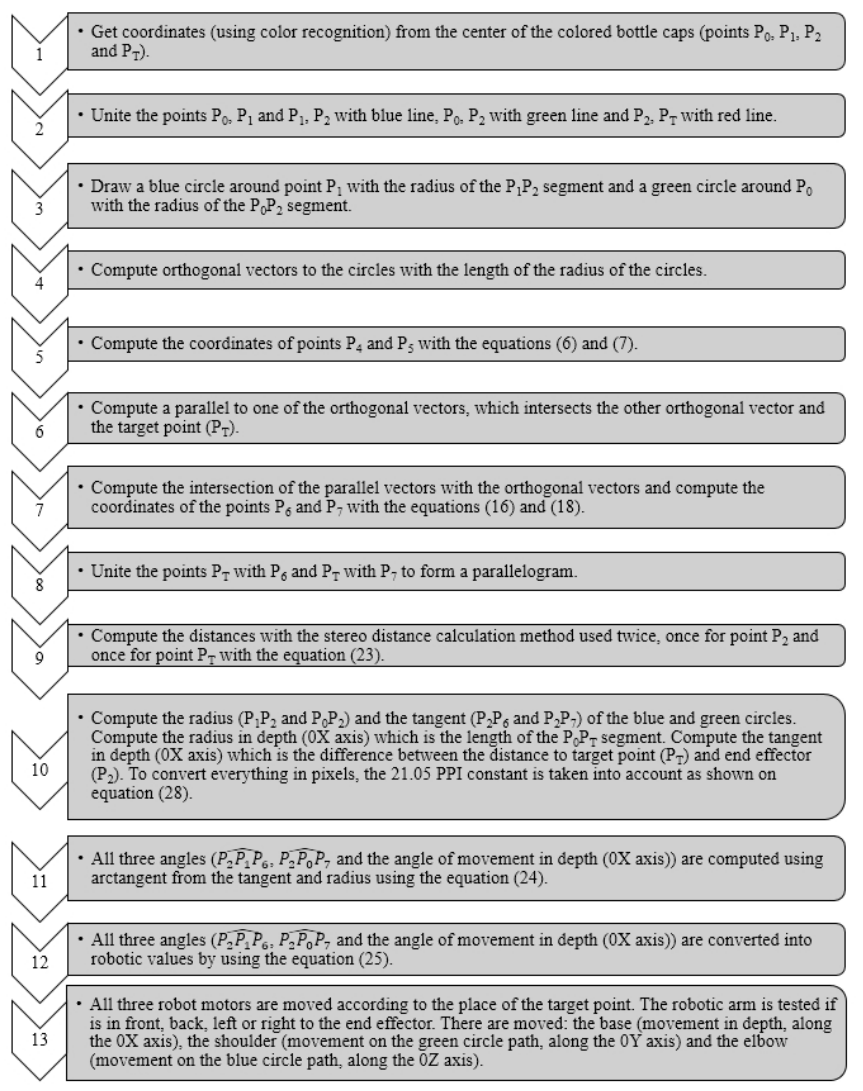
Figure 4. Graphical representation of the steps on how to control a robotic arm using the pro- posed